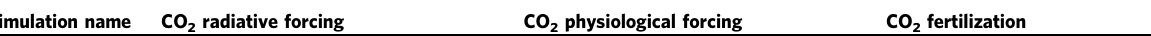
Table 1 CMIP5 simulation names and associated CO 2